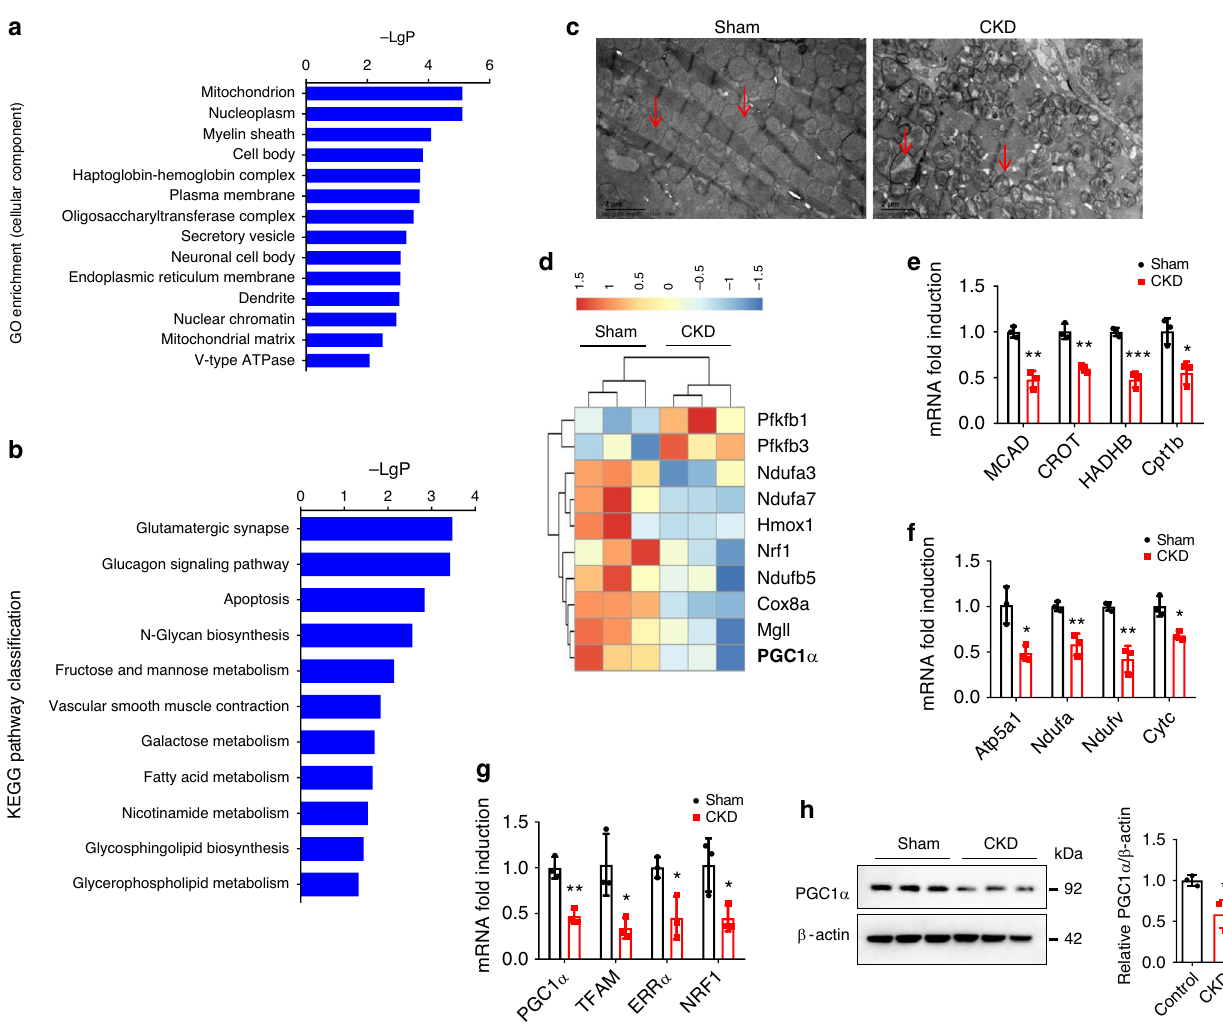
Fig. 1 Myocardial energy metabolism dysfunction and PGC1 α downregulation are observed in the heart of CKD mice. a GO enrichment of the signi fi cantly changed cellular components of the heart from three pairs of sham and CKD mice. b KEGG pathway classi fi cation of differentially expressed genes (DEG) of the heart in sham and CKD mice. c Representative images of transmission electron microscope (TEM) observation of mitochondria of the heart from sham and CKD mice ( n = 3 mice per group). Scale bar, 2 μ m. Red arrows point to mitochondria. d Heatmap of DEG (mainly PGC1 α and its target genes) of mice in a . The color intensity represents row Z -score. Red color indicates highly expressed, while blue indicates lowly expressed. e – g Relative mRNA expression of FAO genes ( e ), OXPHO genes ( f ), and PGC1 α and its target genes ( g ) of the heart from sham and CKD mice. h Western blot analysis of PGC1 α expression of the heart from sham and CKD mice. Microarray data were obtained from three mice per group. Data in a , b are shown as − Log P and were analyzed by Fisher ’ s exact test, adjusted by using Benjamini – Hochberg. Data in e – h are shown as mean ± SD and were analyzed by a two-tailed unpaired t -test ( n = 3). * P < 0.05, ** P < 0.01, *** P <